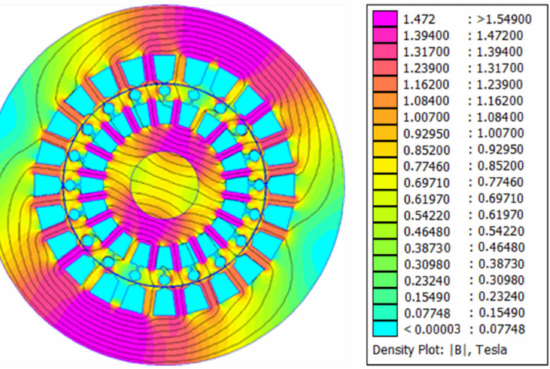
Figure 2. Finite elements method simulation: results in the 7.5 kW